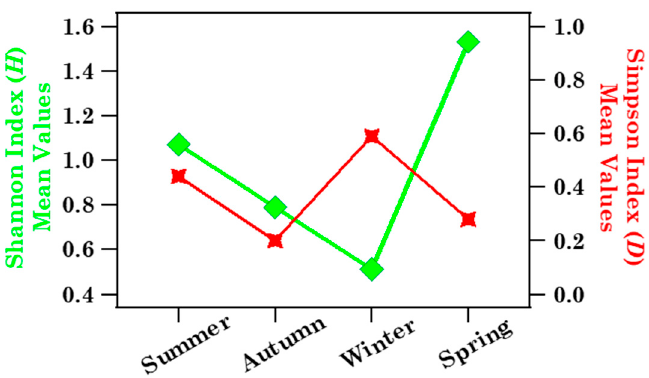
Figure 5. Brindisi Shannon and Simpson index mean values at the family level across the four seasons: summer (July, August, September), autumn (October, November, December), winter (January, February, March), and spring (April, May, June). Solid lines join the discrete data points to better visualise their respective seasonal trend.